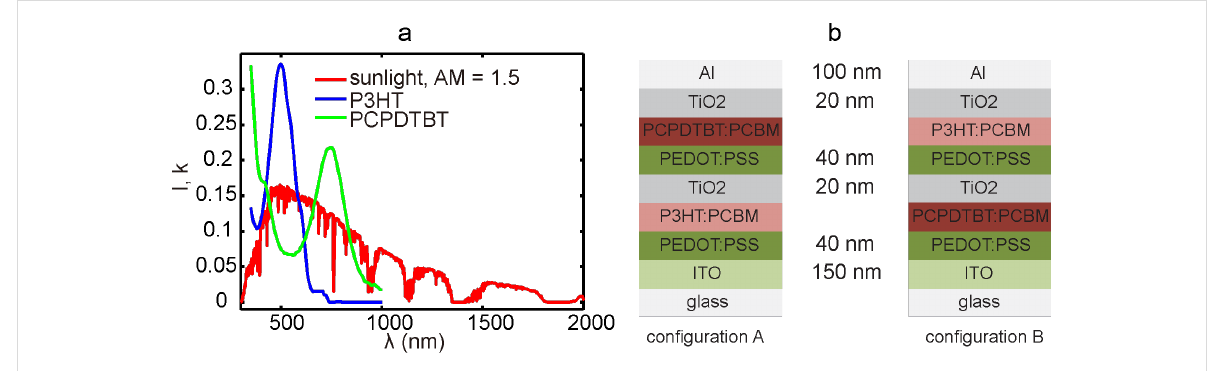
Figure 1: (a) Spectrum of sunlight and different active materials used in tandem organic solar cells. (b) The two configurations (configuration A: left; configuration B: right) of tandem polymer solar cells investigated in this